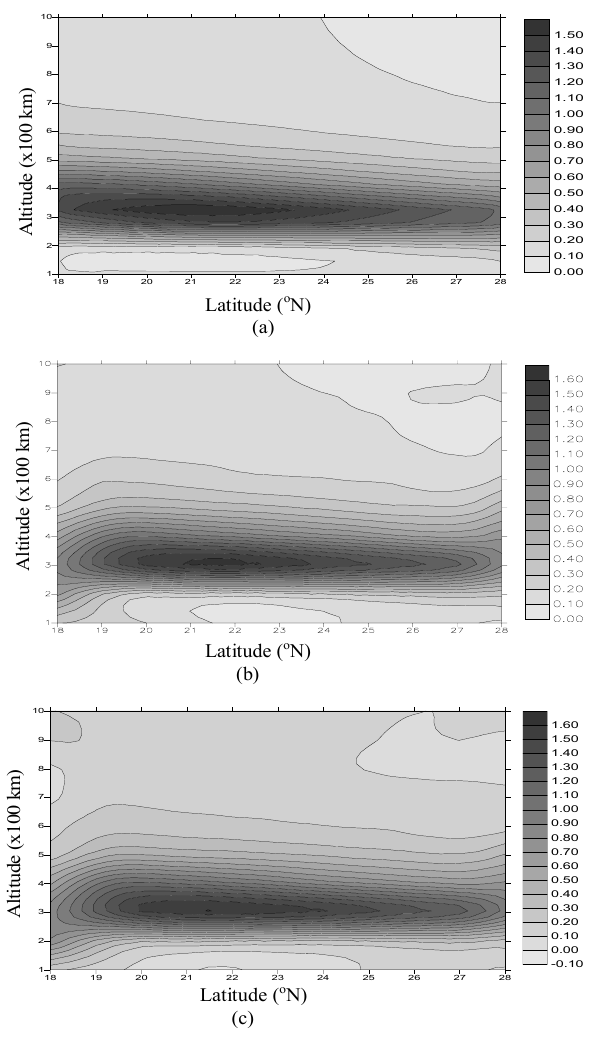
Fig. 1. ( a ) Electron Density (10 6 cm − 3 ) distribution obtained from IRI 2001 ( b ) GSVD reconstruction using 220 ray paths ( c ) recon- struction with 250 ray paths.